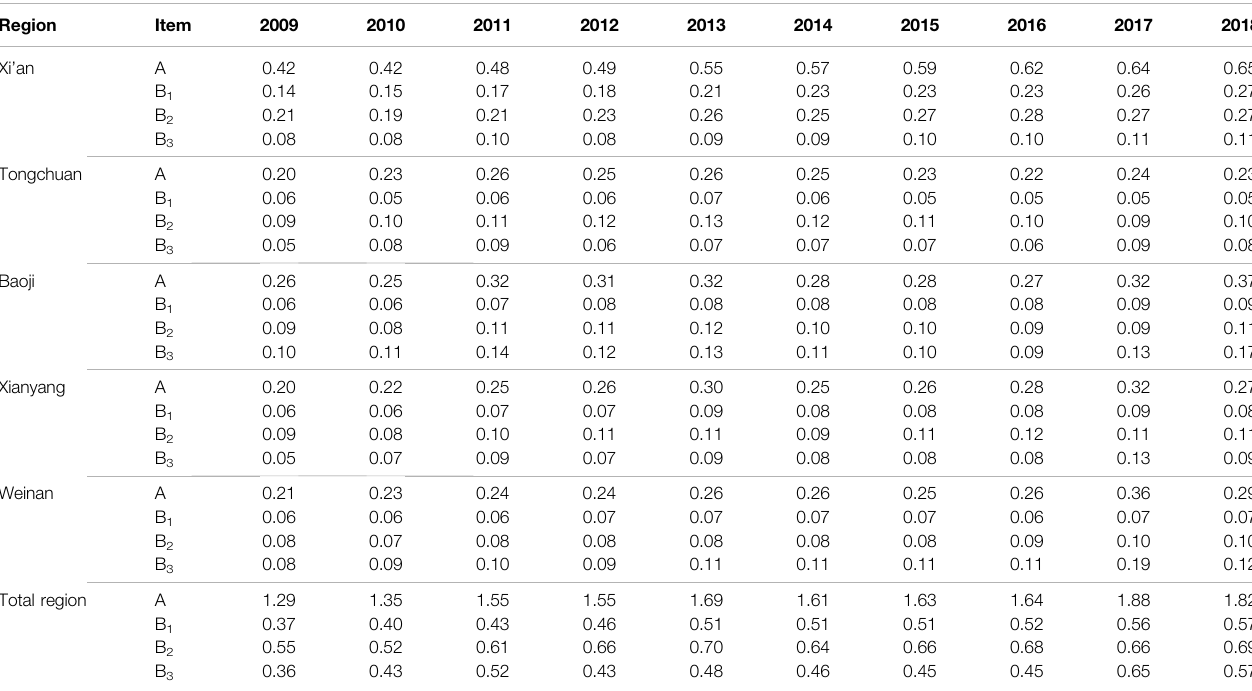
TABLE 2 | The assessment results on river basin sustainable development. Region